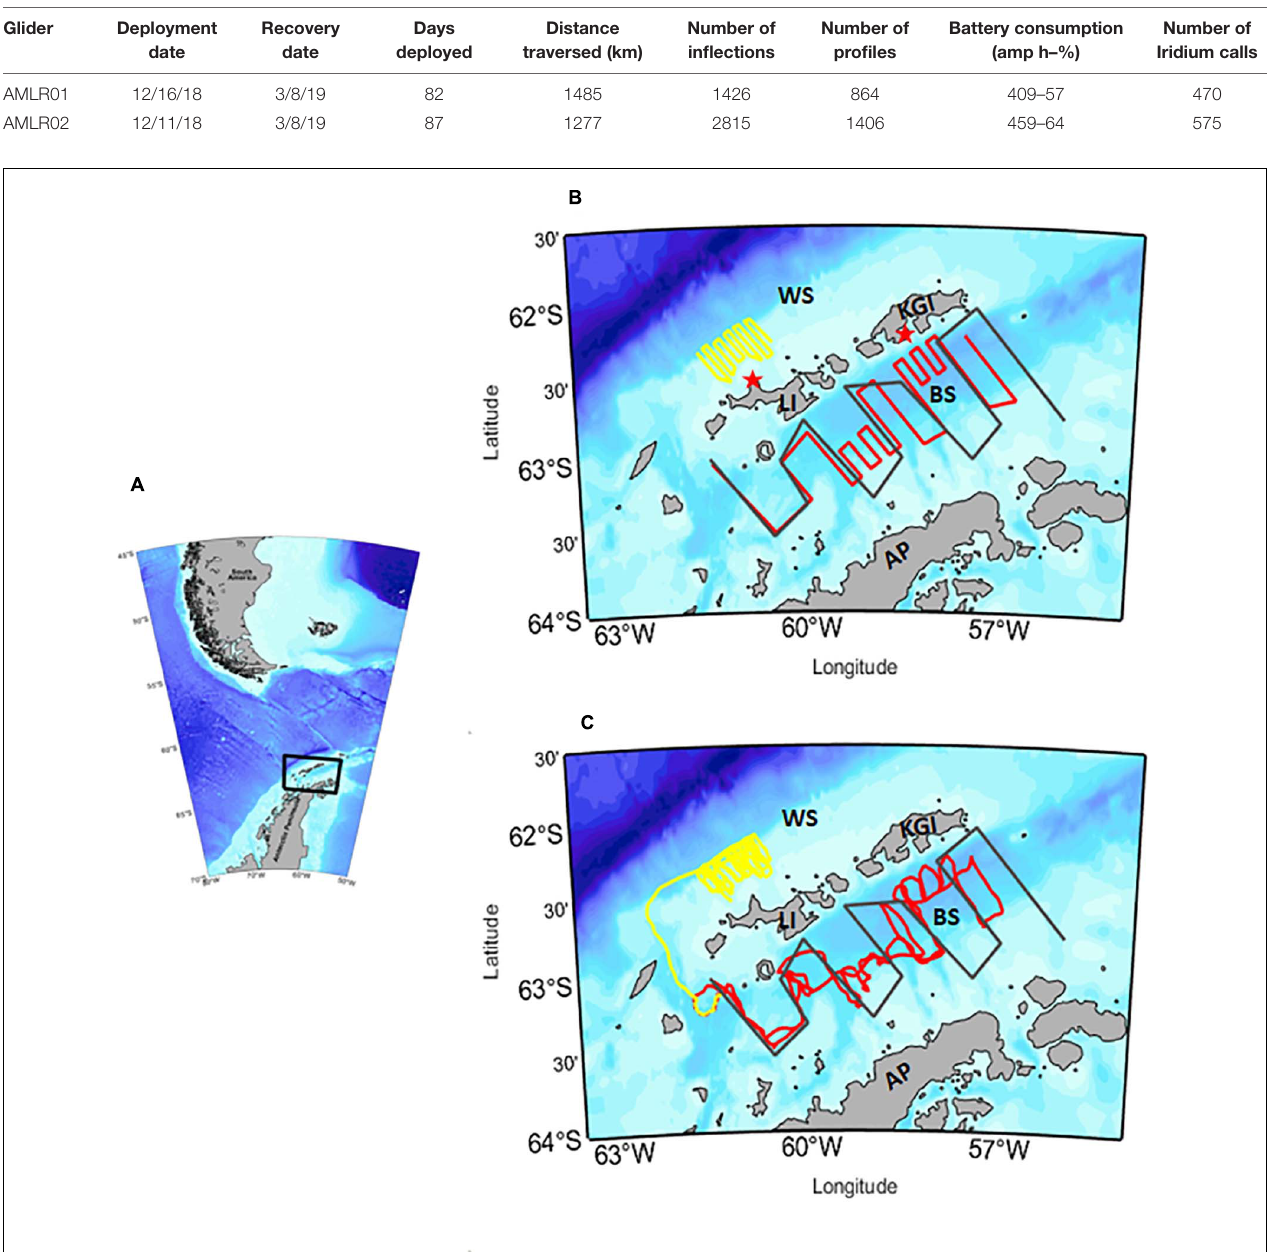
FIGURE 1 | (A) Map of South America and the region surrounding the northern Antarctic Peninsula (AP) showing the region in which gliders were deployed (black box). (B) Map showing planned track lines of acoustically-equipped gliders deployed from mid-December 2018 to mid-March 2019 in two areas: the West Shelf (WS) off Livingston Island (LI; yellow) and the Bransfield Strait (BS; red). Planned track lines for previous ship-based surveys in the Bransfield Strait are illustrated as gray lines. Red stars indicate the locations of U.S. AMLR field camps at Cape Shirreff, LI and in Admiralty Bay, King George Island (KGI), where krill were sampled from penguin diets and used to construct length-frequency distributions. (C) Actual paths of gliders in a restricted area on the WS and in the BS, with planned track lines for previous ship-based surveys in Bransfield Strait for reference (gray lines). Repeat small-scale surveys were conducted in the restricted area (yellow lines)